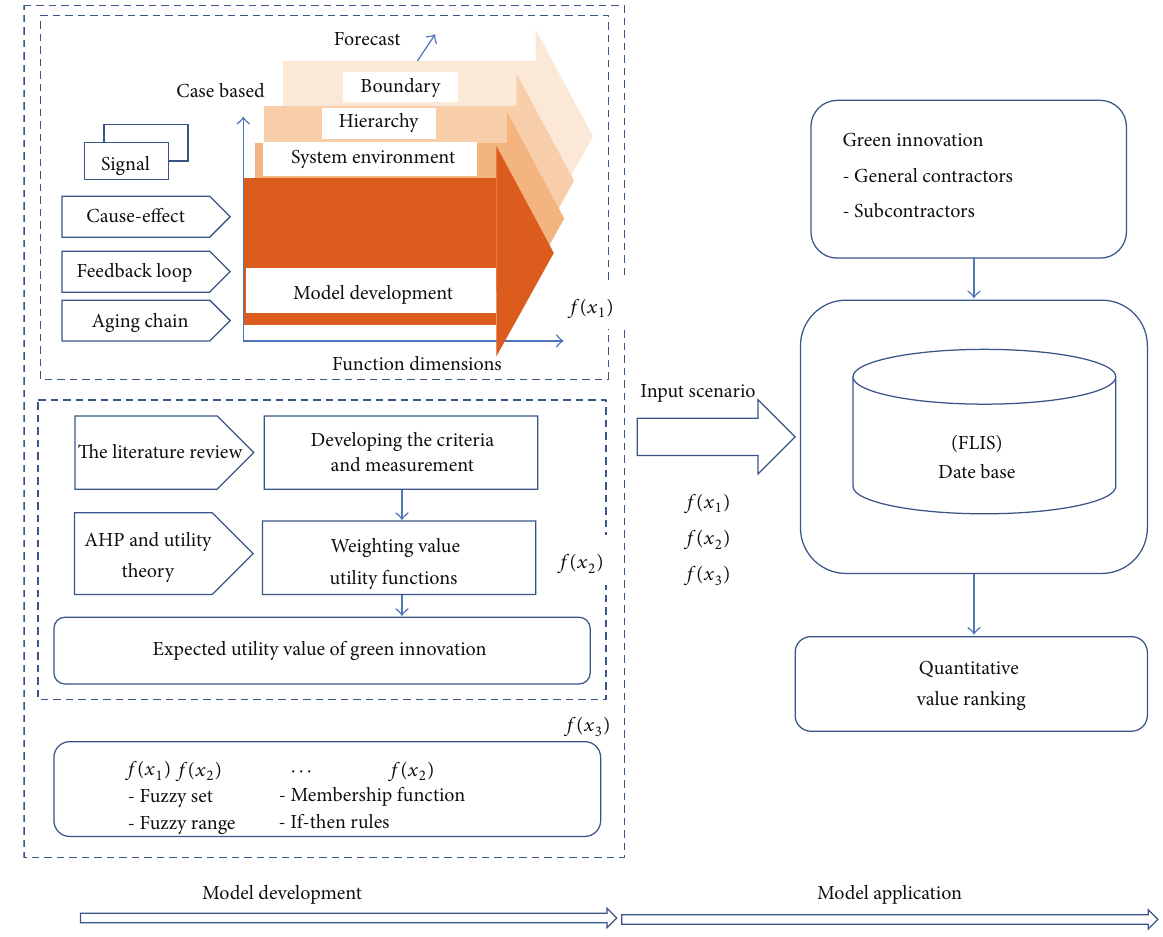
Figure 1: The proposed assessment